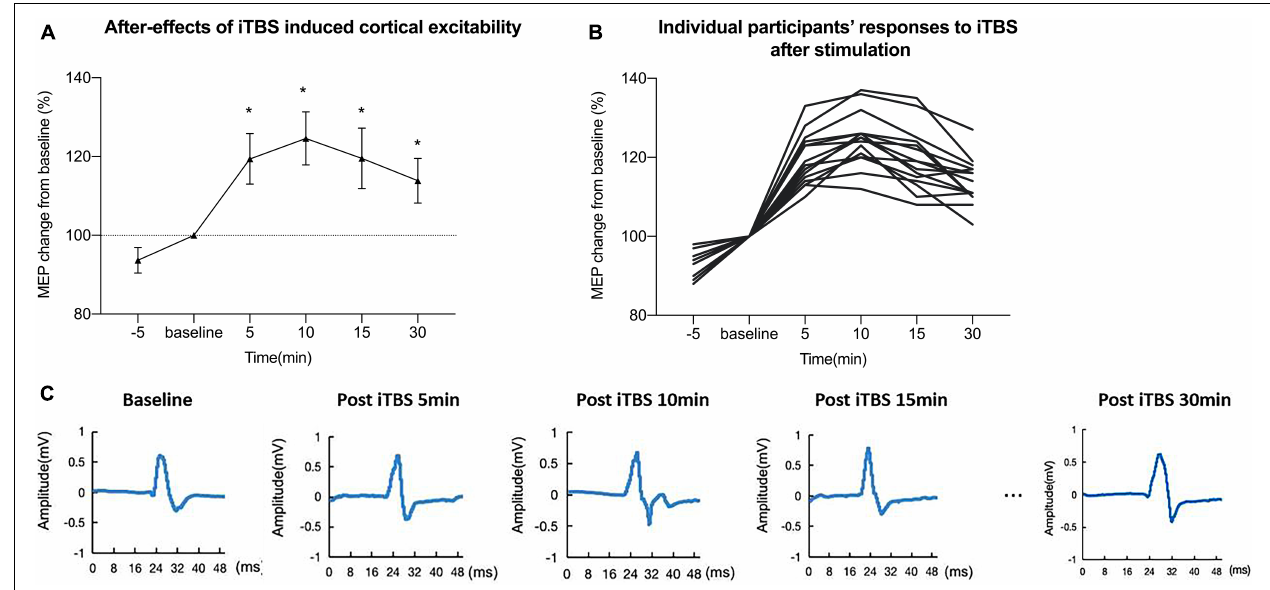
FIGURE 2 | Intermittent theta burst stimulation (iTBS) induced increase in cortical excitability at different time points. (A) iTBS induced a mean increase in motor-evoked potential (MEP) amplitude at different time points after intervention. (B) Individual responses to iTBS after stimulation of each participant. (C) Representative traces in motor-evoked potentials (MEPs) recorded at 5, 10, 15, and 30 min after stimulation. The data indicated that the MEP amplitude began to increase after conducting